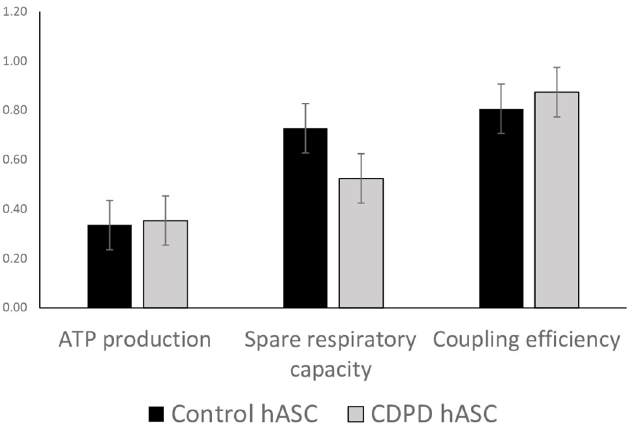
Fig 6. Oxidative parameters: ATP production, spare respiratory capacity and coupling efficiency of the mitochondrial respiratory chain. ATP production was calculated as (basal-H+ leak), spare respiratory capacity % was calculated as (maximal/basal), and coupling efficiency was calculated as (ATPprod/basal). No significant differences were found between the control and CDPD hASC lines. AU, arbitrary units; hASC, human adipose stem cells; CDPD , clinically diagnosed Parkinson’s